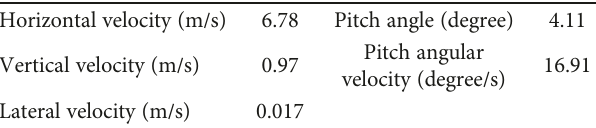
Table 2: Missile ’ s initial disturbance parameters.